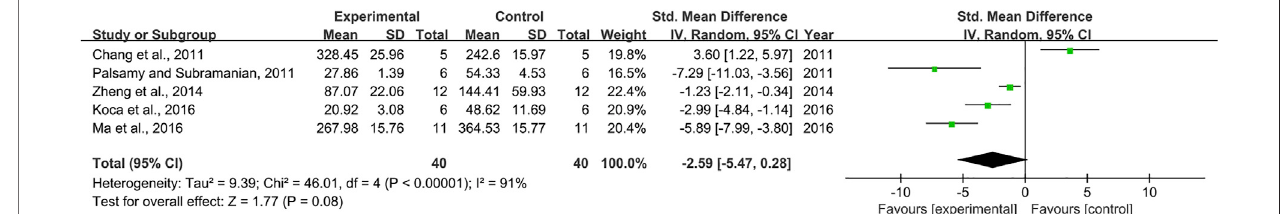
FIGURE 11 | Pooled estimate of IL-6 with RSV.